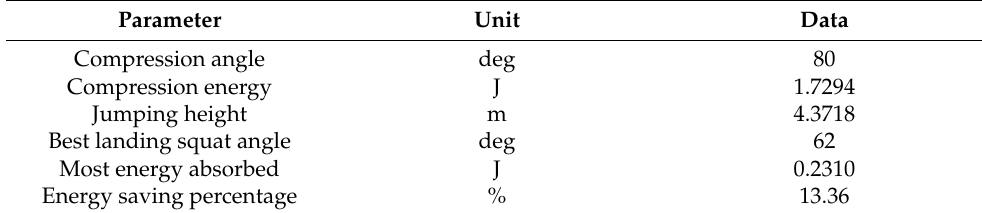
Table 2. Results analysis of the dropping height at 4.3718 m.